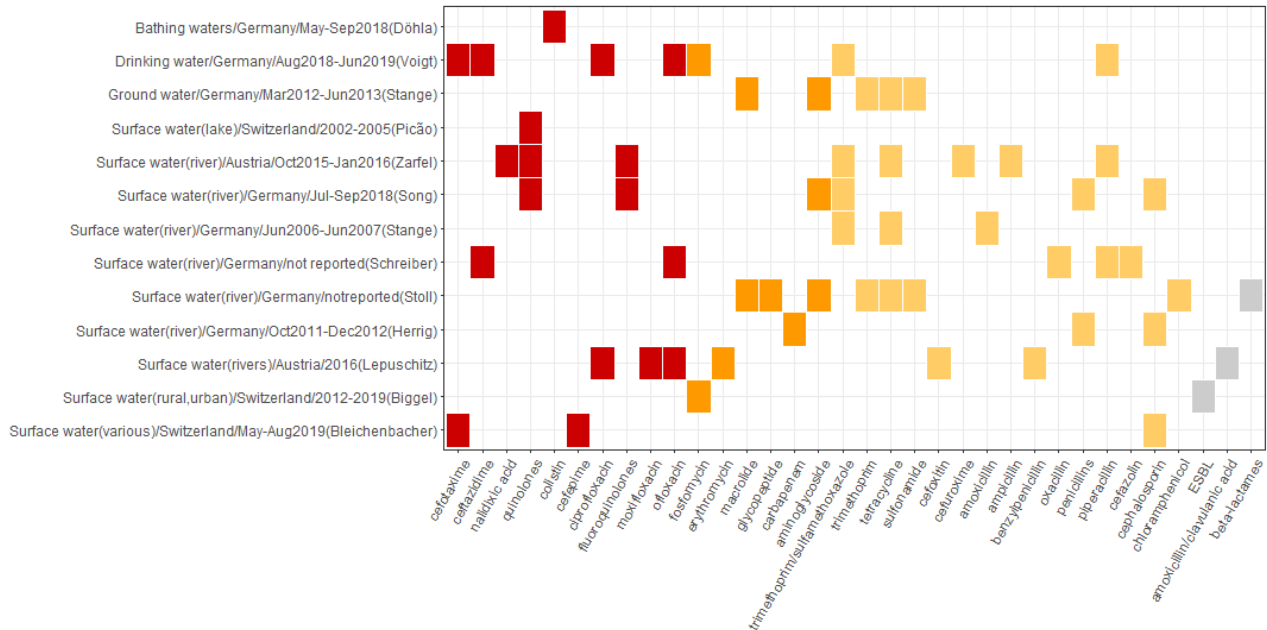
Figure 3. Overview of the occurrence of reported antibiotic resistance patterns in water sources. The horizontal axis depicts resistance patterns as reported in the primary studies and includes antibiotic compounds, antibiotic classes, resistance mechanisms, and ARGs. The vertical axis represents the source of resistance associated with resistance patterns depicted on the horizontal axis as follows: source of sample/Country of study/Sampling period/(First author of the reporting study). The color profile represents the WHO CIA list categories: red, Critically important: Highest Priority; orange, Critically important: High Priority; yellow, Highly important; grey, not listed.